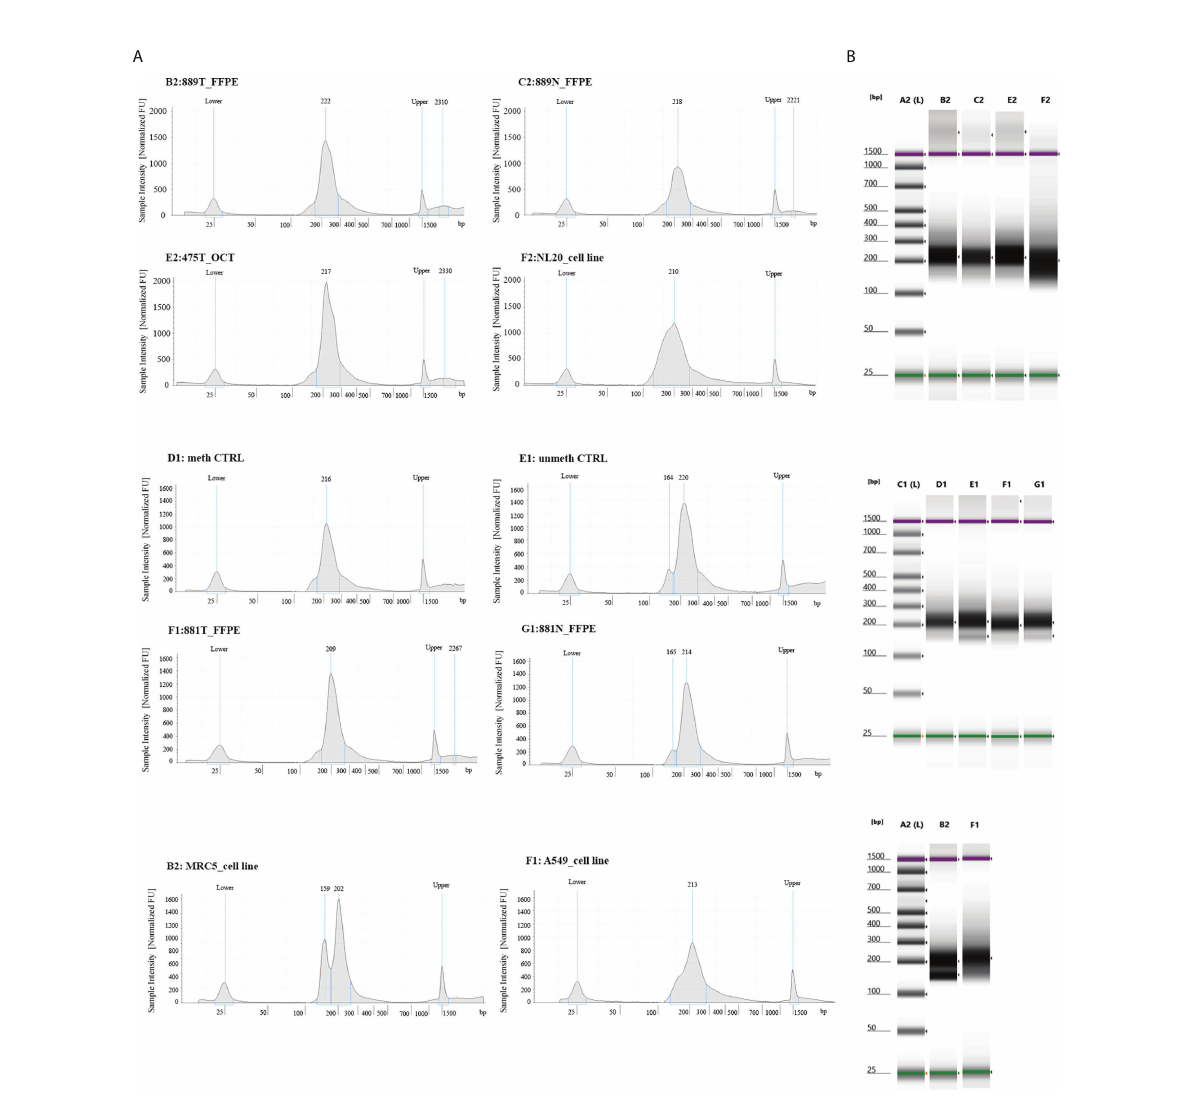
FIGURE 1 Quality control steps of library construction using the OPERA_MET-A panel for targeted next generation bisul fi te sequencing. (A) Representative picture of chromatograms showing a high quality library pro fi le of methylated and unmethylated DNA control samples and eight gDNA samples